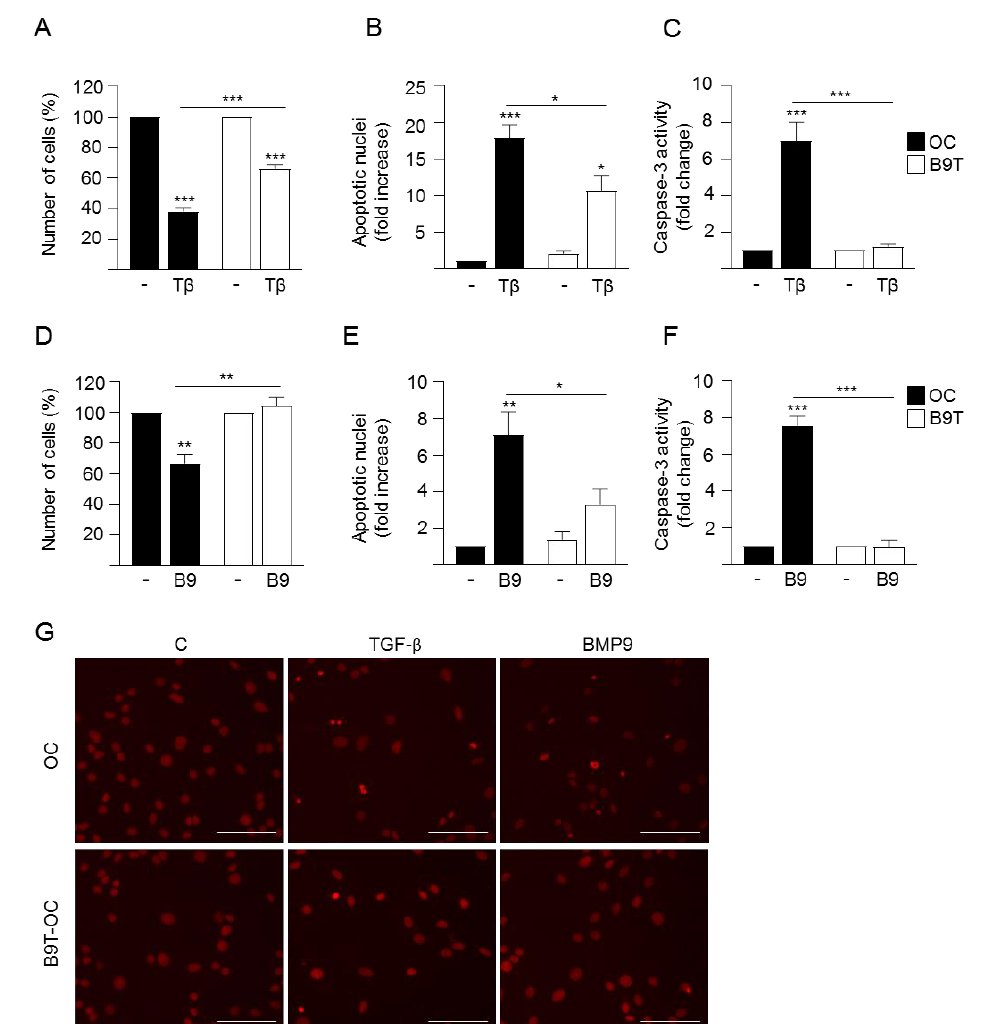
Figure 4. B9T-OC are more resistant to BMP9 and TGF- β -induced apoptosis than OC. ( A – C ). Oval cells (OC) and B9T-OC were serum-starved and incubated in the presence of TGF- β (2 ng/mL) for 48 h. ( A ) Cells were counted. Data from three independent experiments performed in triplicate are shown and expressed as percentage of untreated cells (mean ± SEM). ( B ) Apoptotic index was calculated by counting apoptotic nuclei after PI staining under a fluorescence microscope. A minimum of 1000 nuclei was counted per condition. Data from four independent experiments performed in triplicate (mean ± SEM) are shown and are expressed relative to untreated OC (assigned an arbitrary value of 1). ( C ) Caspase-3 activity. Data are mean ± SEM of four experiments and are expressed as a fold change of untreated cells. ( D – F ) OC and B9T-OC were serum-starved and incubated in the presence of BMP9 (2 ng/mL) for 48 h. ( D ) Cells were counted. Data from three independent experiments performed in triplicate are shown and expressed as percentage of untreated cells (mean ± SEM). ( E ). Apoptotic index was calculated as in ( B ). Data from four independent experiments performed in triplicate (mean ± SEM) are shown and are expressed relative to untreated OC (assigned an arbitrary value of 1). ( F ) Caspase-3 activity. Data are mean ± SEM of four experiments and are expressed as a fold change of untreated cells. ( G ) Representative images of propidium iodide staining taken under a fluorescence microscope used for quantification of apoptosis in ( B , E ). Scale bar = 50 µ m. In all cases, data were compared with the untreated condition or as indicated, * p < 0.05, ** p < 0.01 and *** p <